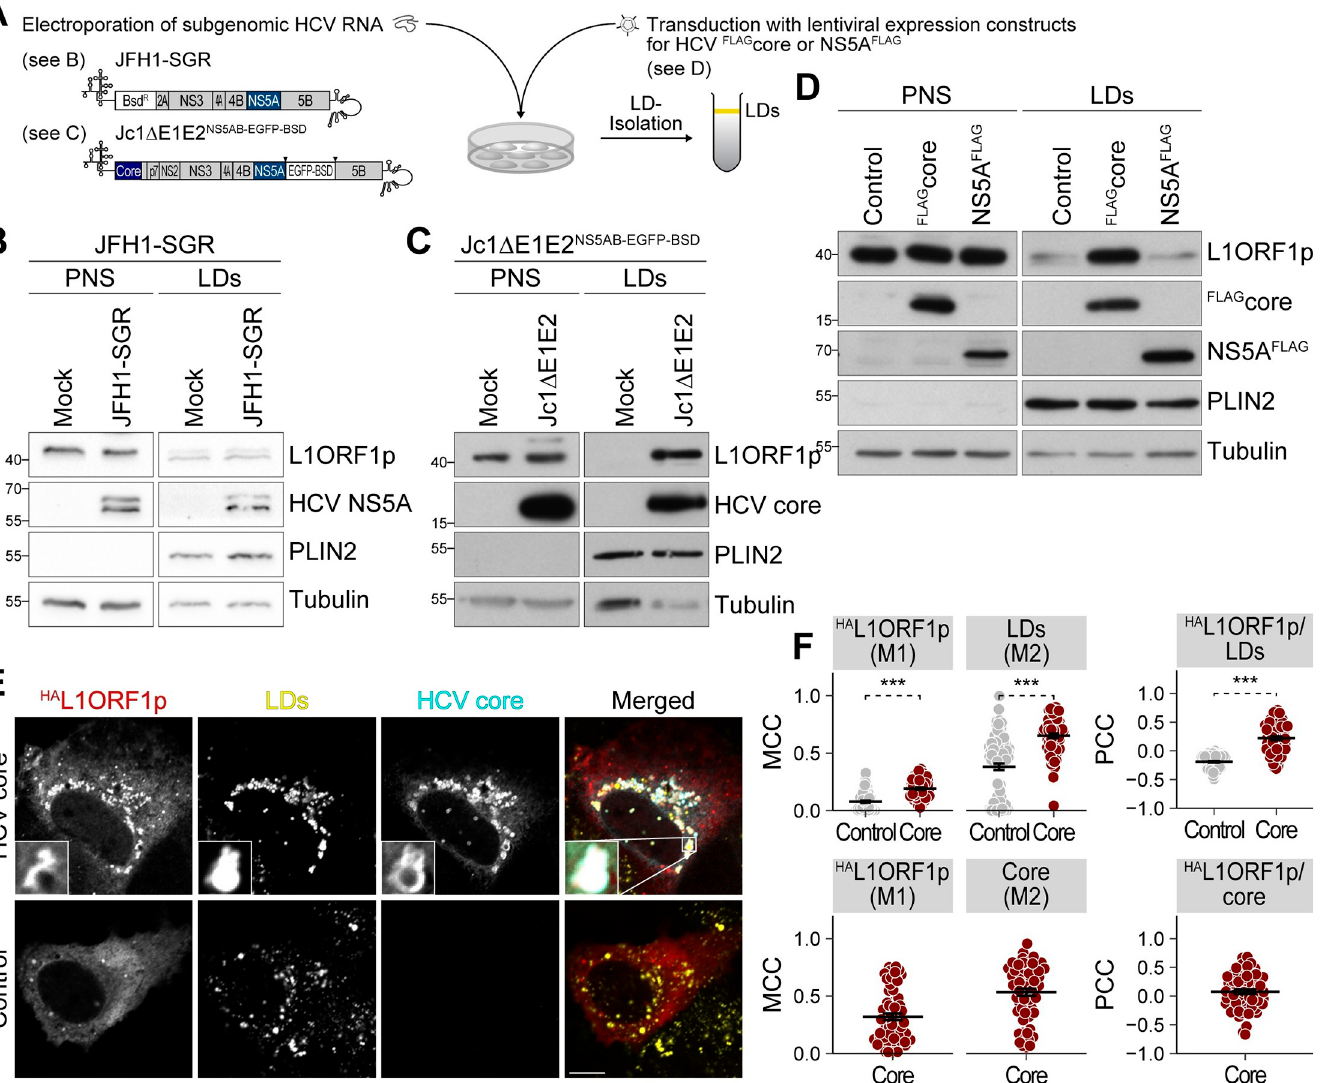
Fig 4. HCV core mediates L1ORF1p redistribution from cytoplasmic foci to lipid droplets. (A) Scheme of the experimental setup. Huh7.5 cells were either electroporated with JFH1 subgenomic replicon (JFH1-SGR BSD , gt 2a) RNA encoding NS3–NS5B (see B) or with a partially envelope-deleted Jc1 replicon Jc1 Δ E1E2 NS5AB-EGFP-BSD (gt 2a, see C), or transduced with lentiviral expression constructs for HCV FLAG core or NS5A FLAG (gt 2a, see D), and lipid droplets were isolated by sucrose density centrifugation. (B–D) Immunoblot analysis of lipid droplet fractions isolated from Huh7.5 cells electroporated with JFH1-SGR BSD (n = 3) (B), Jc1 Δ E1E2 NS5AB-EGFP-BSD (n = 1) (C), or transduced with lentiviral expression constructs for FLAG core or NS5A FLAG (n FLAGcore = 4, n NS5AFLAG = 2) (D). Shown are representative experiments. Tubulin and PLIN2 served as loading controls for post-nuclear supernatants (PNS) and lipid droplets (LDs), respectively. (E) Confocal microscopy of Huh7 cells transfected with HA L1ORF1p and FLAG core (gt 2a) expression plasmids and stained with anti-core and anti-HA tag antibodies and BODIPY493/503 for lipid droplets. Shown are representative images (scale bar 10 μ m). (F) Quantification of colocalization of HA L1ORF1p with lipid droplets and HA L1ORF1p with core as presented in (E). Shown are Manders’ colocalization coefficients (MCC) M1 and M2 and Pearson’s correlation coefficients (PCC) of individual cells from 3 independent experiments (# of cells: control = 91, HCV core = 61; mean ± SEM, ��� p < 0.001, Welch’s t